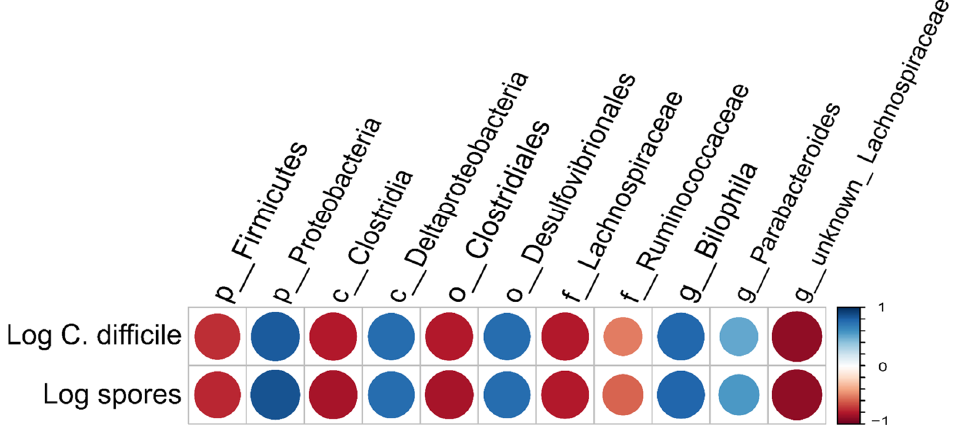
Figure 7. Simplified heatmap on different taxonomic levels where there is a significant correlation (>/< ±0.7) with C. difficile .